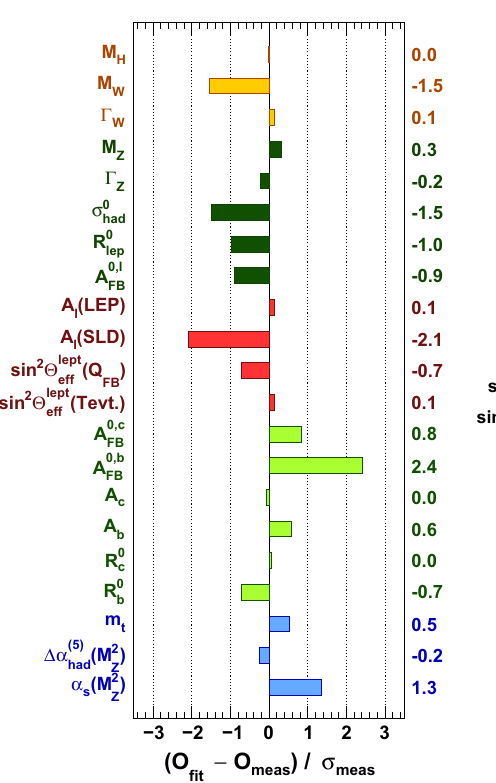
tionsillustratetheimpactoftheiruncertaintiesonthetotaluncertainties. The indirect determination of an observable corresponds to a fit without using the constraint from the corresponding input measurement